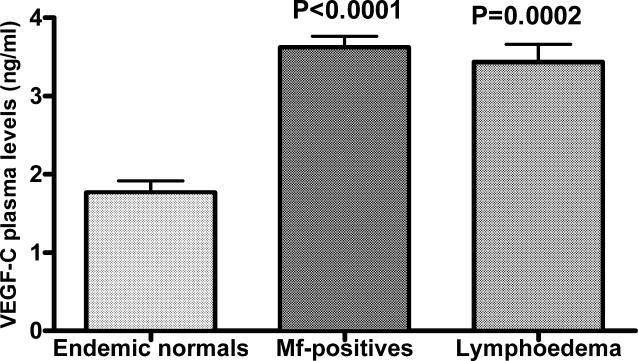
Pretreatment Plasma Levels of VEGF-C in Filarial-Infected Patients and Endemic ControlsPlasma concentrations (mean ± SD) of VEGF-C were measured, using a commercial kit, from plasma of lymphedema patients (n = 26), microfilaremic patients (n = 76), and endemic controls (n = 23, who did not have filarial infection). Mean plasma levels of VEGF-C were significantly elevated in the microfilaremic (p < 0.0001) and lymphedema patients (p = 0.0002) compared to endemic controls (Student t-test with Bonferroni/Dunn correction). There was no difference between microfilaremic and lymphedema patients (p = 0.8033).